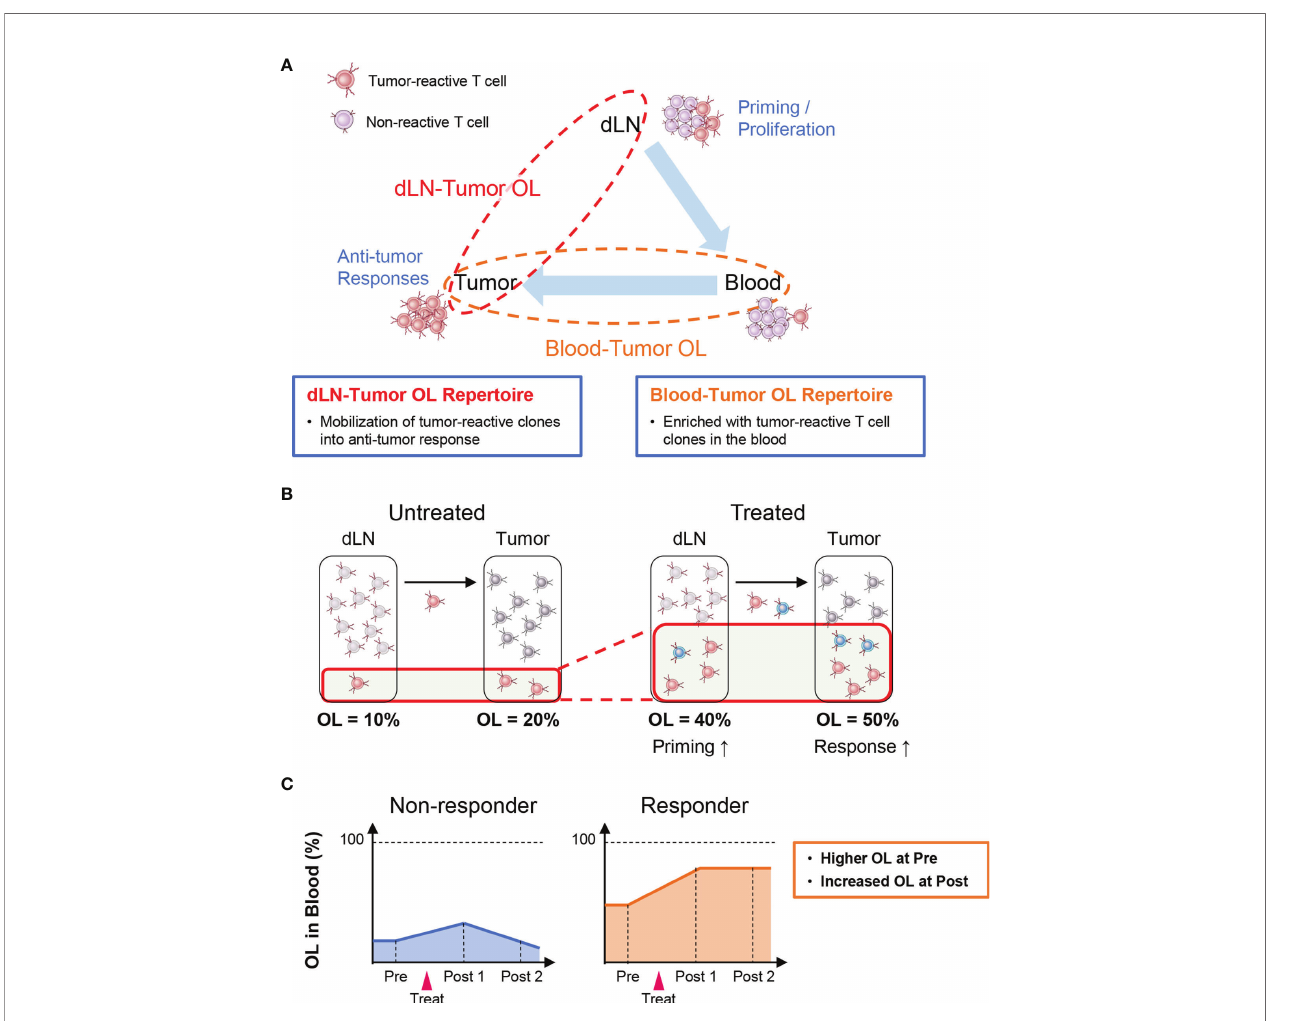
FIGURE 2 | Outline of inter-organ clone tracking analysis. (A) Tumor-reactive T cells are activated and proliferate after antigen presentation in tumor-draining lymph nodes (dLNs) and then in fi ltrate into the tumor tissue via the blood circulation. Therefore, the dLN-tumor overlapping (OL) repertoire re fl ects a novel mobilization of tumor-reactive clones into the antitumor T-cell response. In addition, the blood-tumor OL repertoire is expected to be enriched in tumor-reactive T-cell clones. (B) Overview of dLN-tumor overlapping repertoire analysis. An increase in overlapping clones is associated with enhanced priming of tumor-reactive clones and stronger antitumor effects. (C) Overview of blood-tumor OL repertoire analysis. Patients with a higher blood-tumor overlap in the blood at baseline and an increase in blood-tumor overlap following treatment show a better antitumor